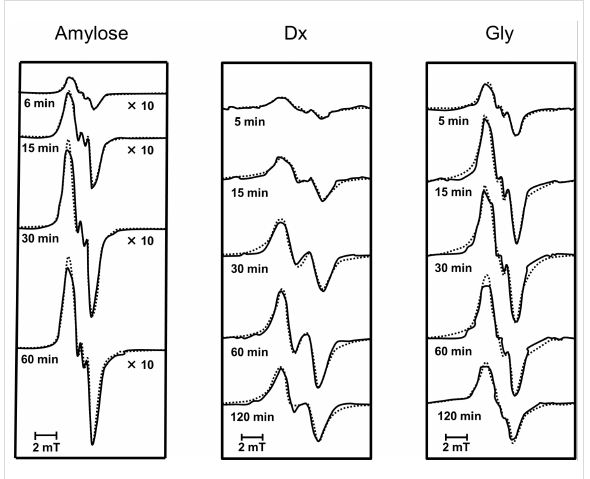
Figure 3: Progressive changes in observed ESR spectra of fractured amylose [5], Dx, and Gly, together with simulated spectra (shown as dotted